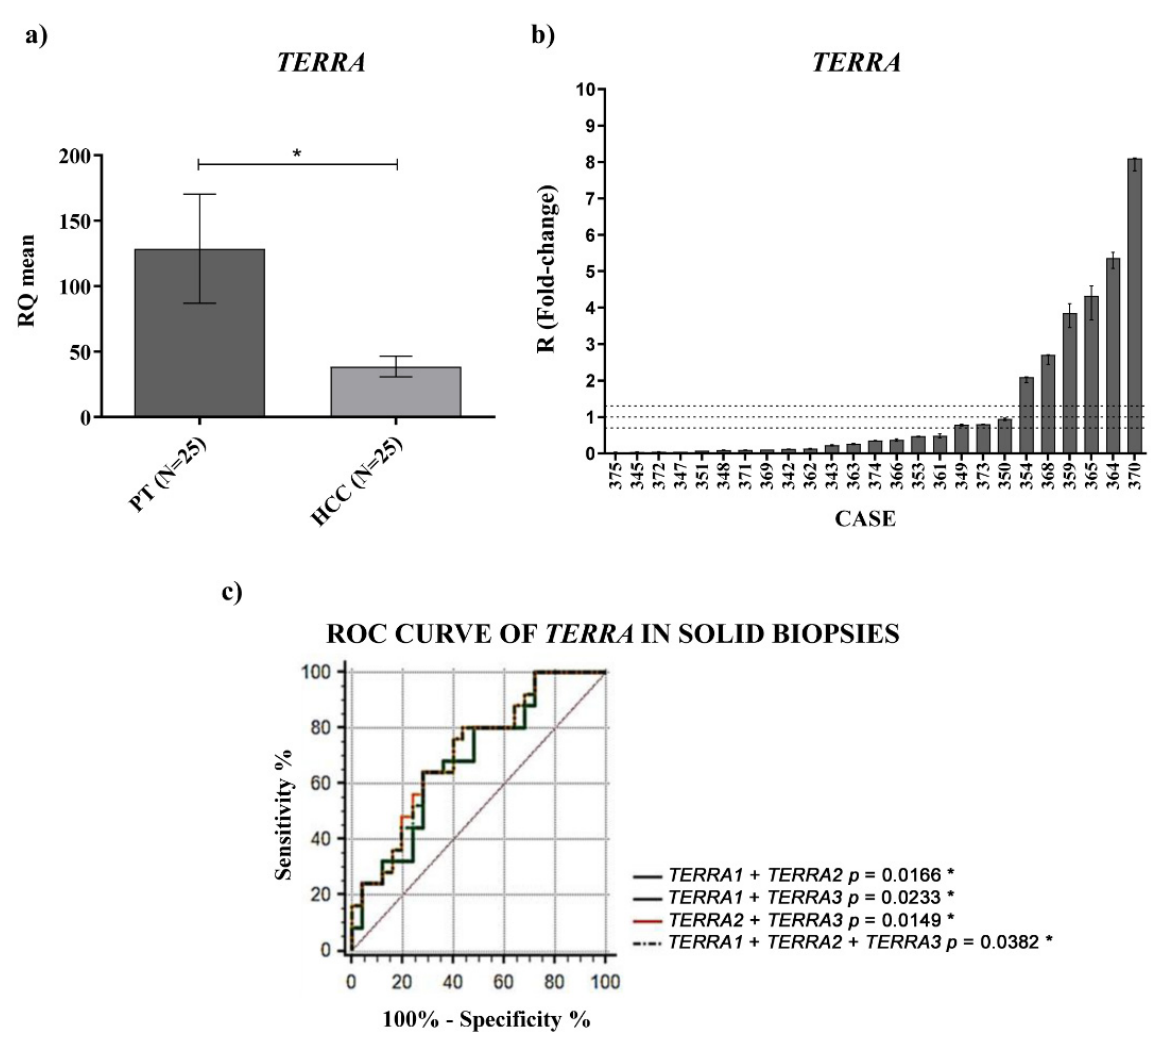
Figure 1. Tissue expression of TERRA . ( a ) TERRA relative quantification mean comparison between PT and HCC. Wilcoxon test was used. ( b ) TERRA fold-change. Histograms represent R-values and bars upper and lower limits. Histograms are ordered by increasing R-values. The corresponding cases are listed on x axis. Upper and lower dot lines define the range of gene expression variation. ( c ) ROC curve analysis of TERRA in tissues. Sensitivity: percent of correctly classified HCC patients. Specificity: percent of correctly classified non-HCC. AUC: area under the ROC curve; CI: confidence interval. * p < 0.05. Table 1. Diagnostic performance of TERRA in HCC